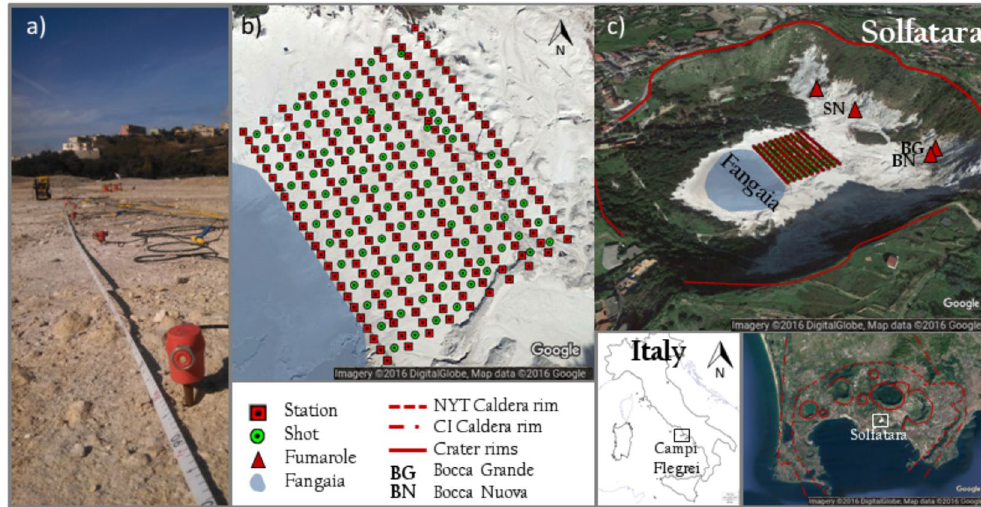
Figure 1. Solfatara with station-shot configuration. ( a ) A photo of the RICEN experiment, with an example of seismic sensors. ( b ) Station-shot configuration. ( c ) The Solfatara crater, with evidence of crater rims, fumarole, Fangaia and the station-shot configuration. The maps in Fig. 1b,c has been obtained with Google Maps 9.38.1 2016 (Map data: Google, DigitalGlobe): Solfatara, Pozzuoli, Metropolitan City of Naples, Italy retrieved